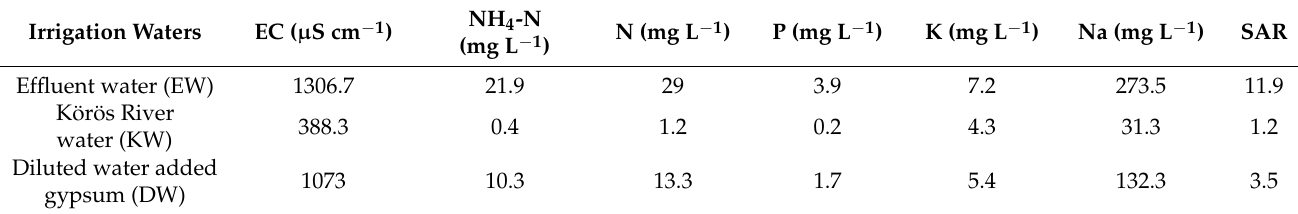
Table 1. Properties of the experimental irrigation water according to Kolozsv á ri et al. [13].